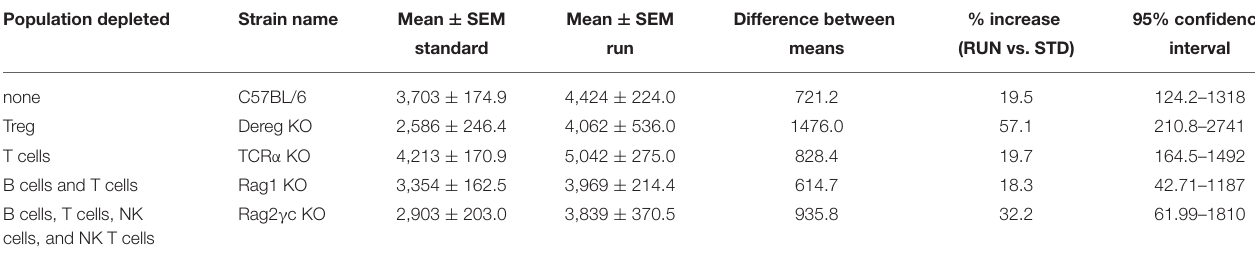
TABLE 1 | All lymphocyte-depleted transgenic lines showed a similar percentage increase in proliferation following physical activity. Population